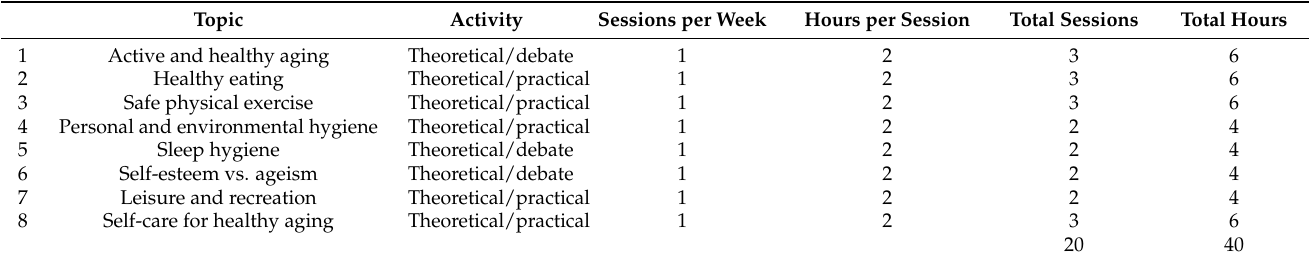
Table 1. Topics of the community gerontology program for healthy aging.